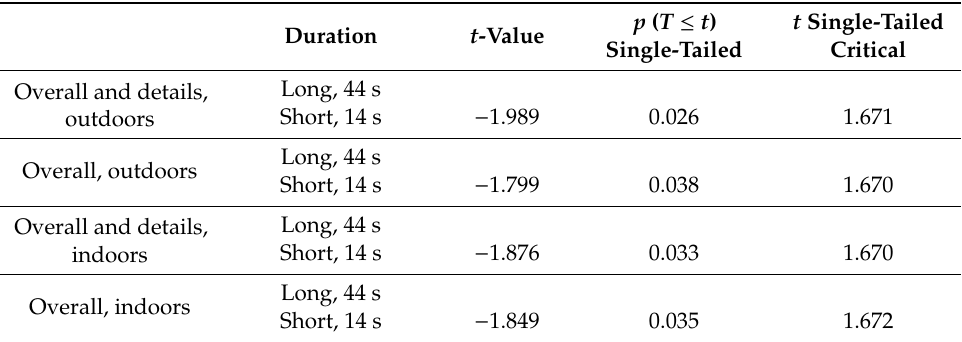
Table 8. The t -tests for the impacts of video displays with di ff erent lengths on consumers’ perceptions of quality.